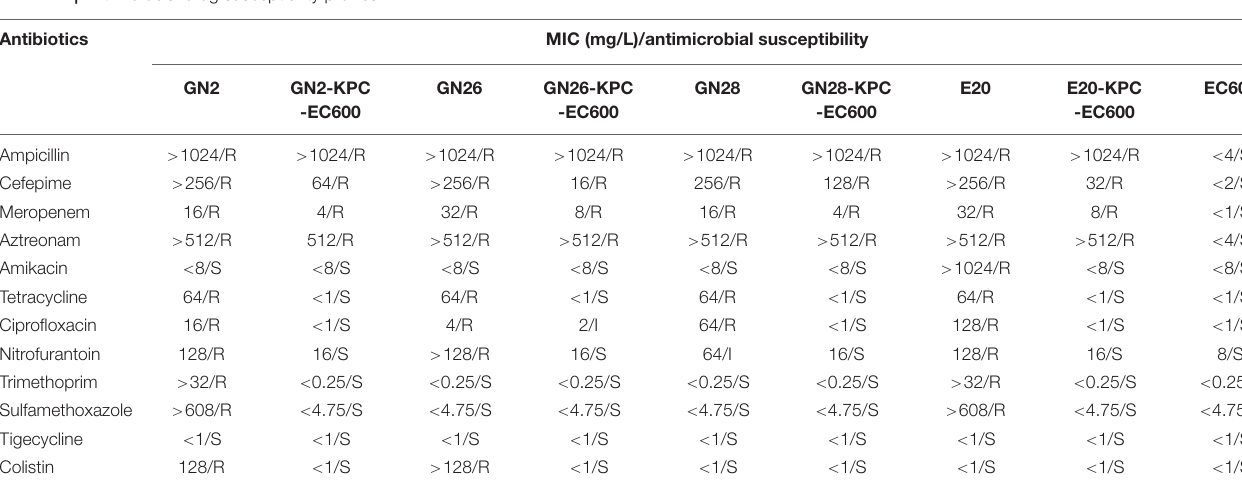
TABLE 2 | Antimicrobial drug susceptibility